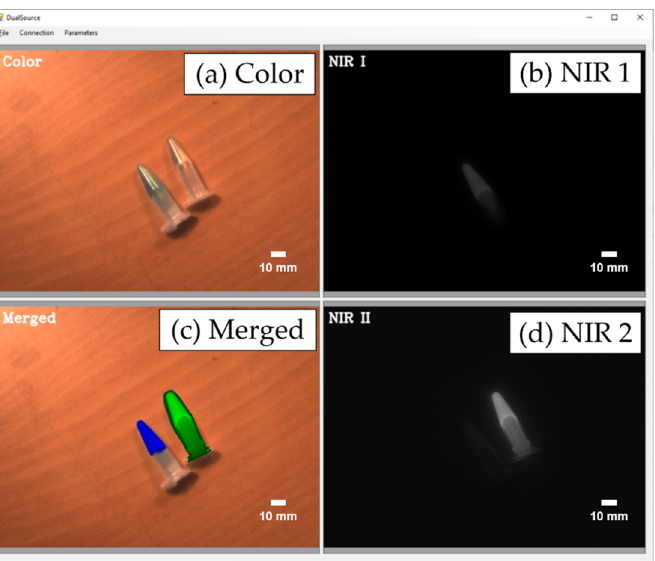
Figure 4. Real-time display images of methylene blue (MB) and indocyanine green (ICG). ( a ) Color image; ( b ) NIR 1 image (MB); ( c ) pseudo color merged image; ( d ) NIR 2 image (ICG).